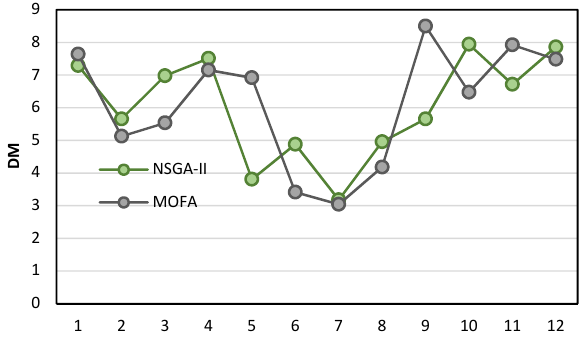
Figure 9. NSGAII and MOFA comparison based on the diversity metric.